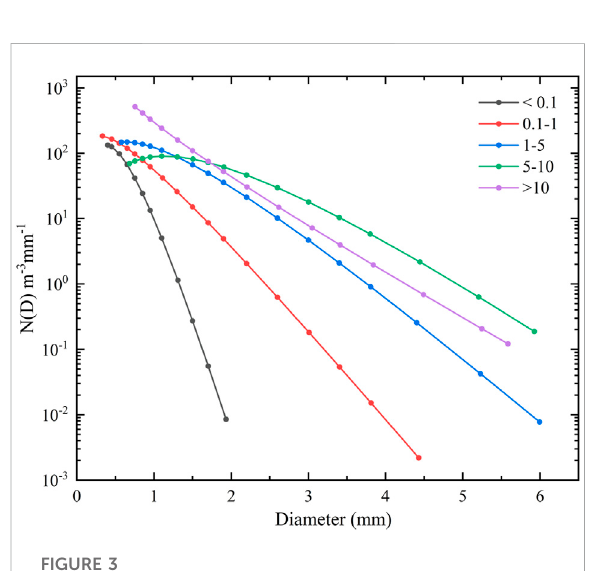
FIGURE 3 The average raindrop size distribution for the fi ve rainfall rate classes in the head watershed of the Urumqi River